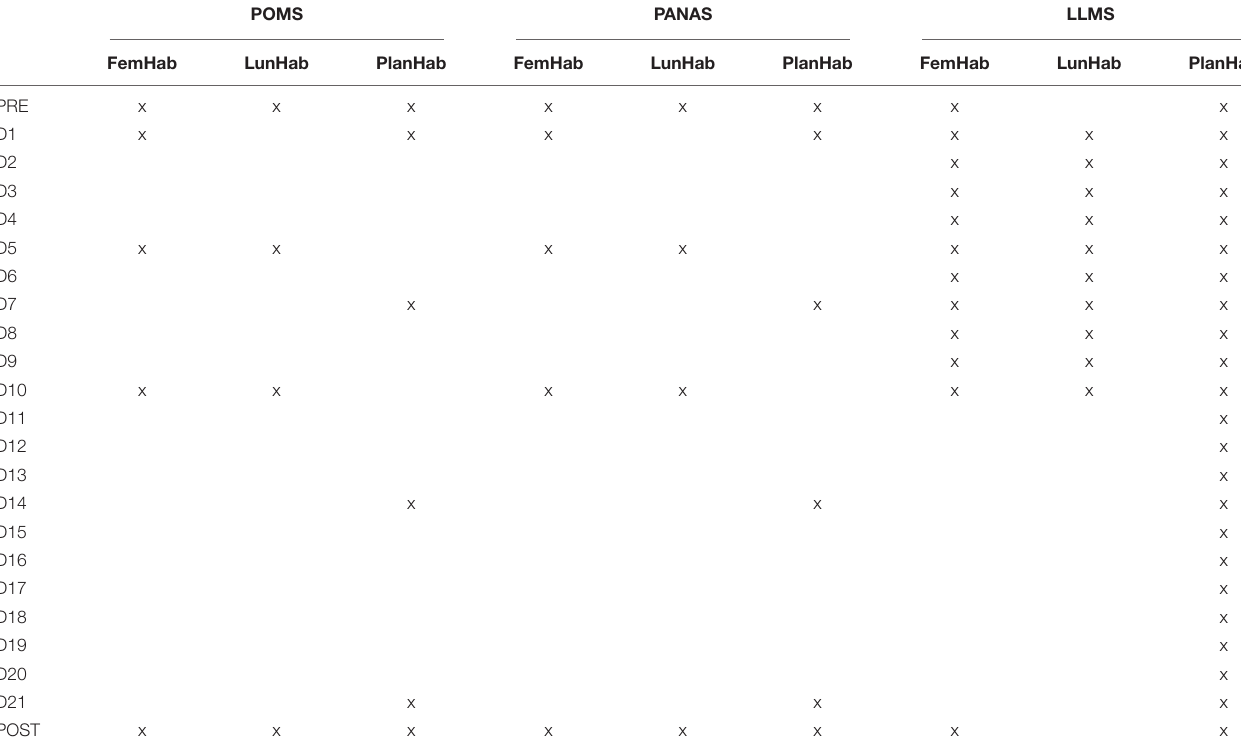
TABLE 2 | Measurement day